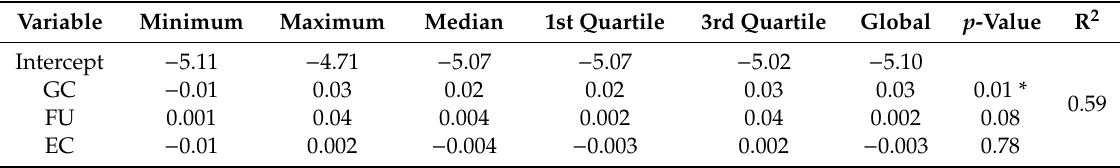
Table 3. Results of the geographic weighted regression (GWR) model by